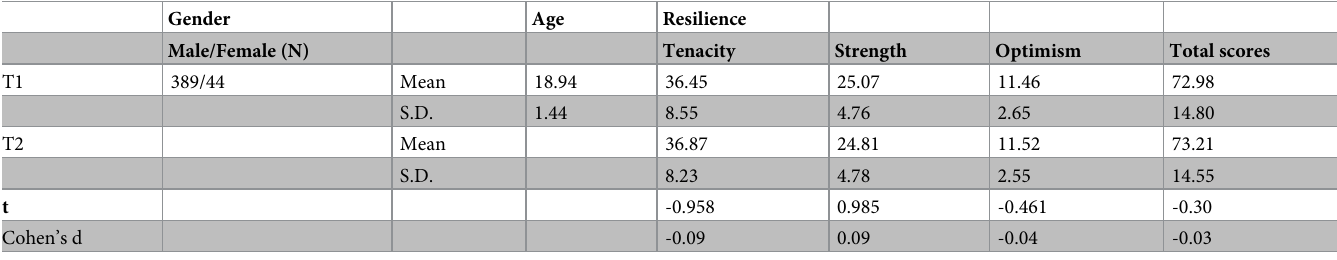
Table 1. Basic information about the early-adulthood